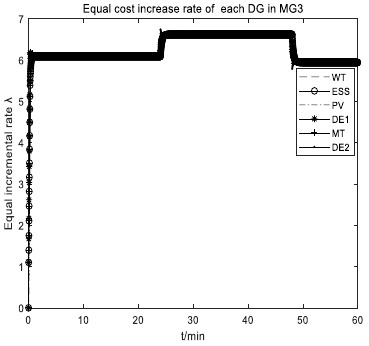
Figure 11. Equal cost increase rate of each